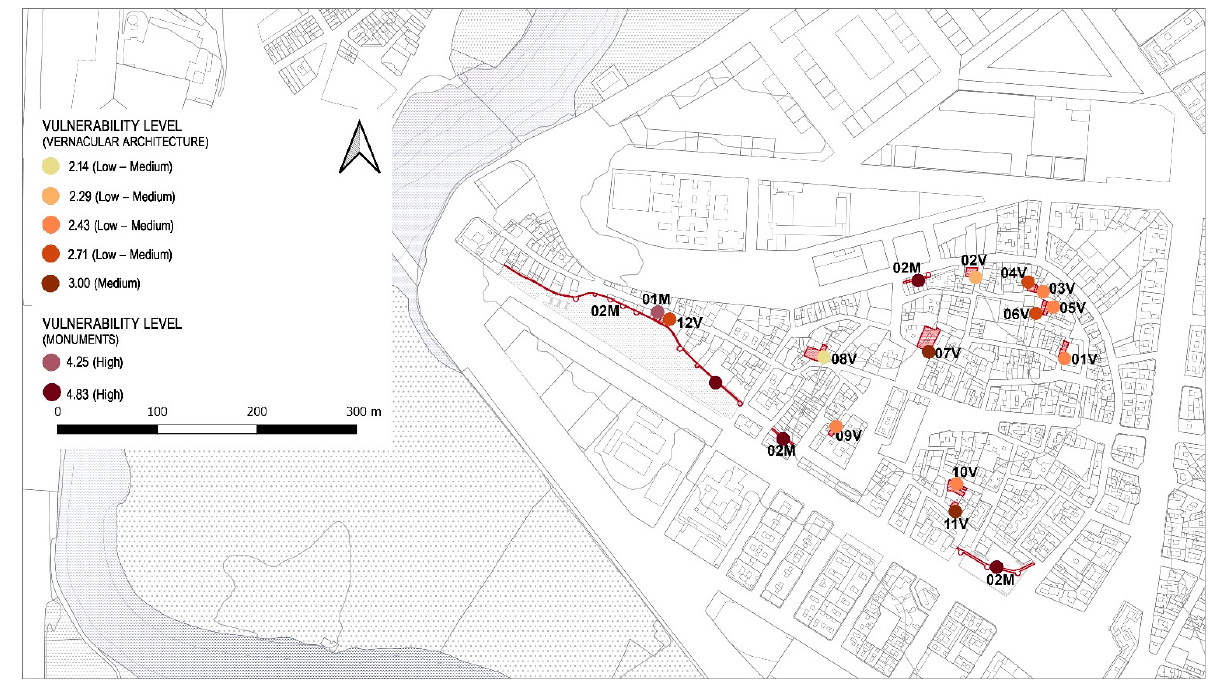
Figure 8. Building vulnerability map.